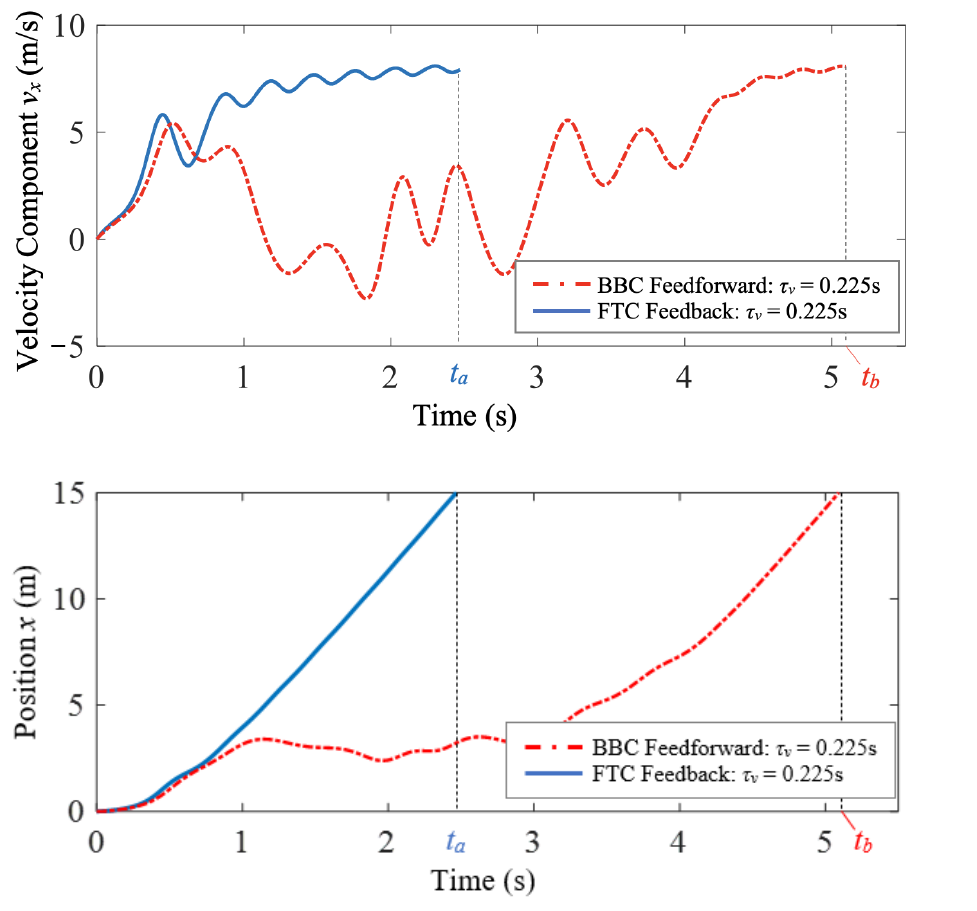
Figure 10. Case study 3: the comparison of horizontal velocity and position time histories of the FTC- controlled and BBC-controlled vehicles shows that the FTC-controlled vehicle reaches the desired horizontal position much faster than the BBC-controlled